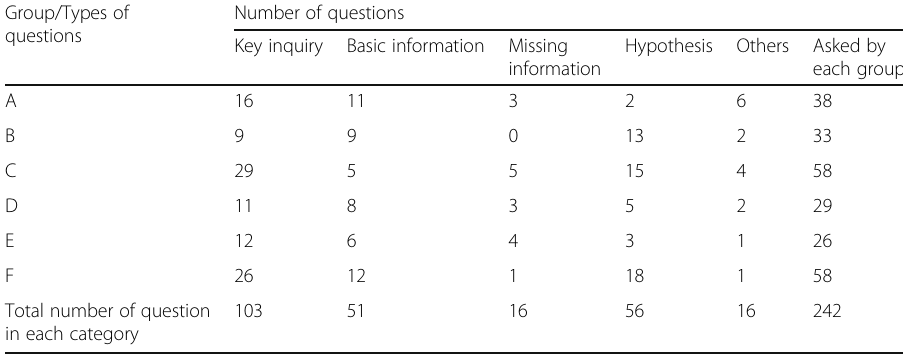
Table 4 Distribution of oral and written questions by numbers and types for all six students